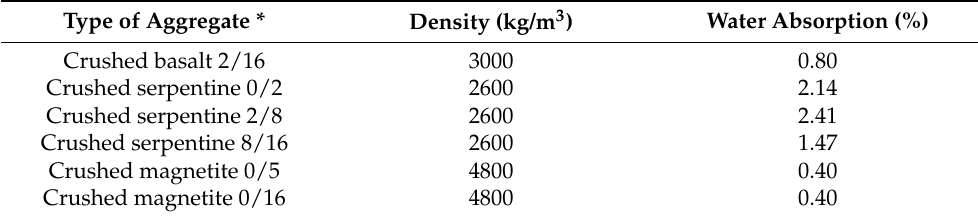
Table 2. The properties of the crushed aggregates [10].